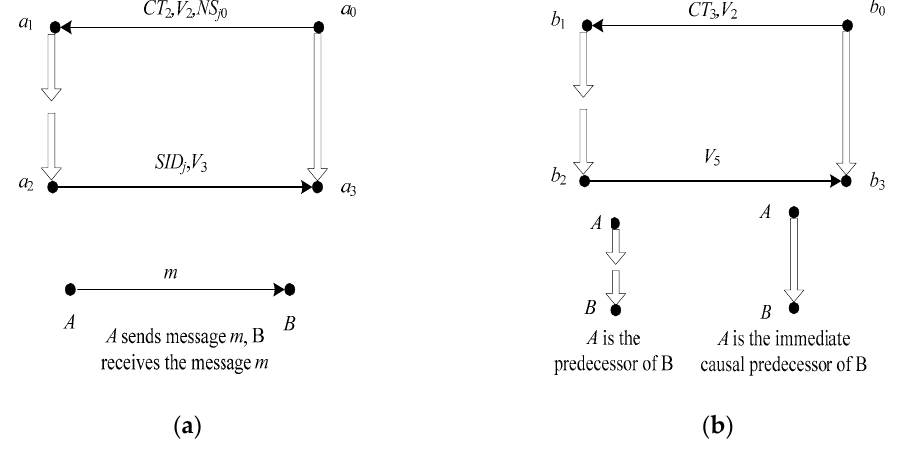
Figure 8. The nodes of a GWN’s strand. ( a ) The nodes a 0  a 1  a 2  a 3; ( b ) The nodes b 0  b 1 Figure A1. The nodes of a GWN’s strand. ( a ) The nodes a 0 ≺ a 1 ≺ a 2 ≺ a 3 ; ( b ) The nodes b 0 ≺ b 1 ≺ b 2 ≺ b 3  b 2  b 3 .